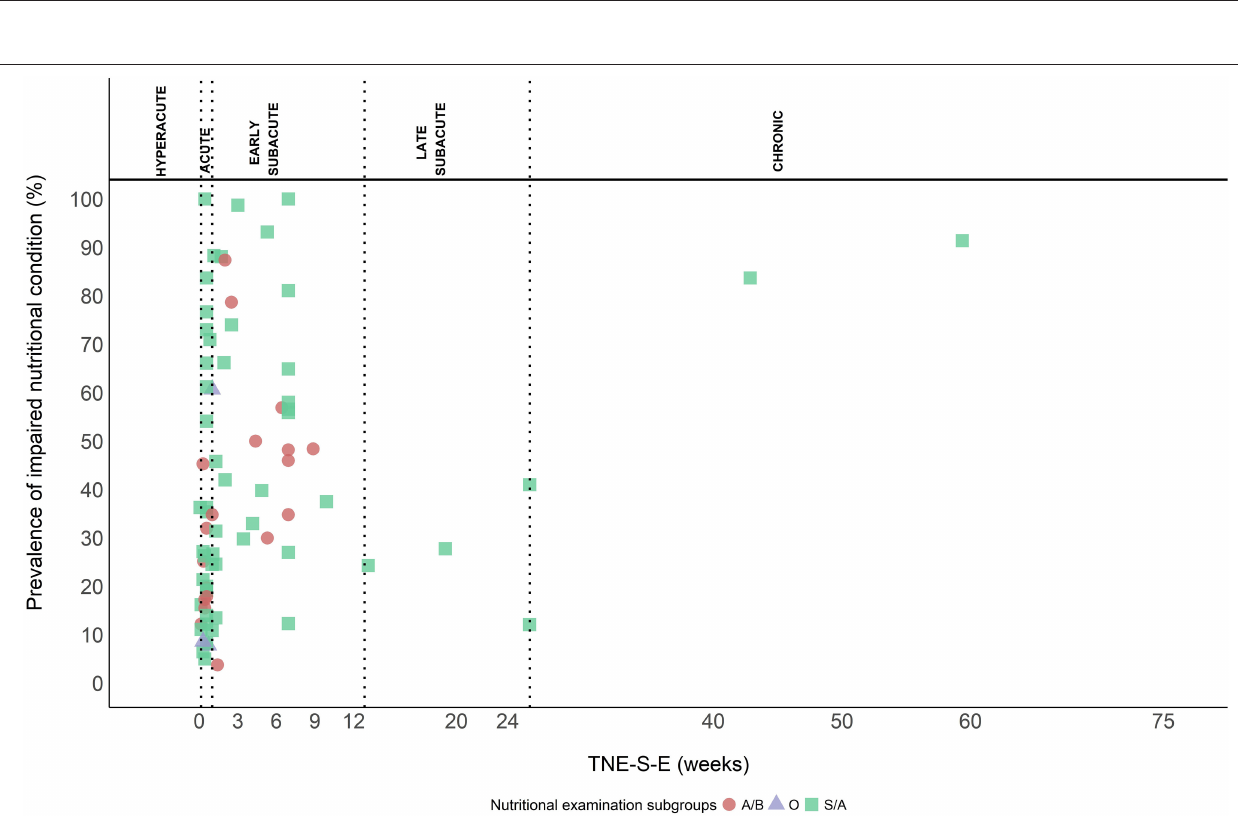
Frontiers in Neurology |